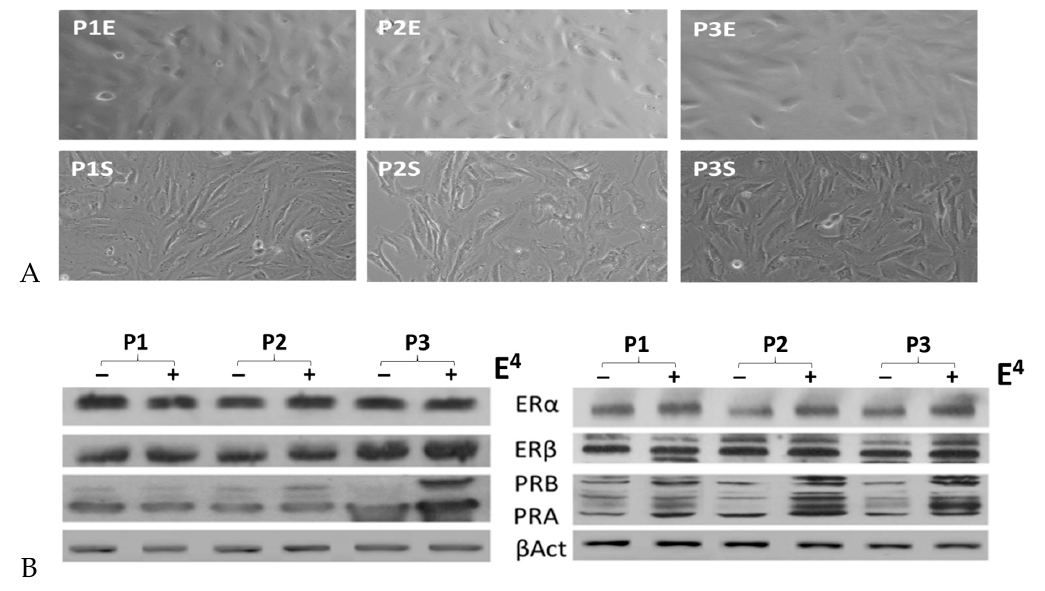
Figure 4. E4 effect in endometrial primary culture cells. ( A ) 20 × images of primary cultures, (top) epithelial cells (bottom) stromal cells. ( B ) Western blot analysis of primary culture cells. (left) epithelial cells (right) stromal cells.